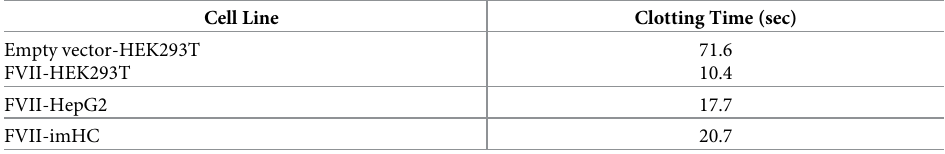
Table 1. Coagulant activity of FVII determined by one-stage clotting assay.